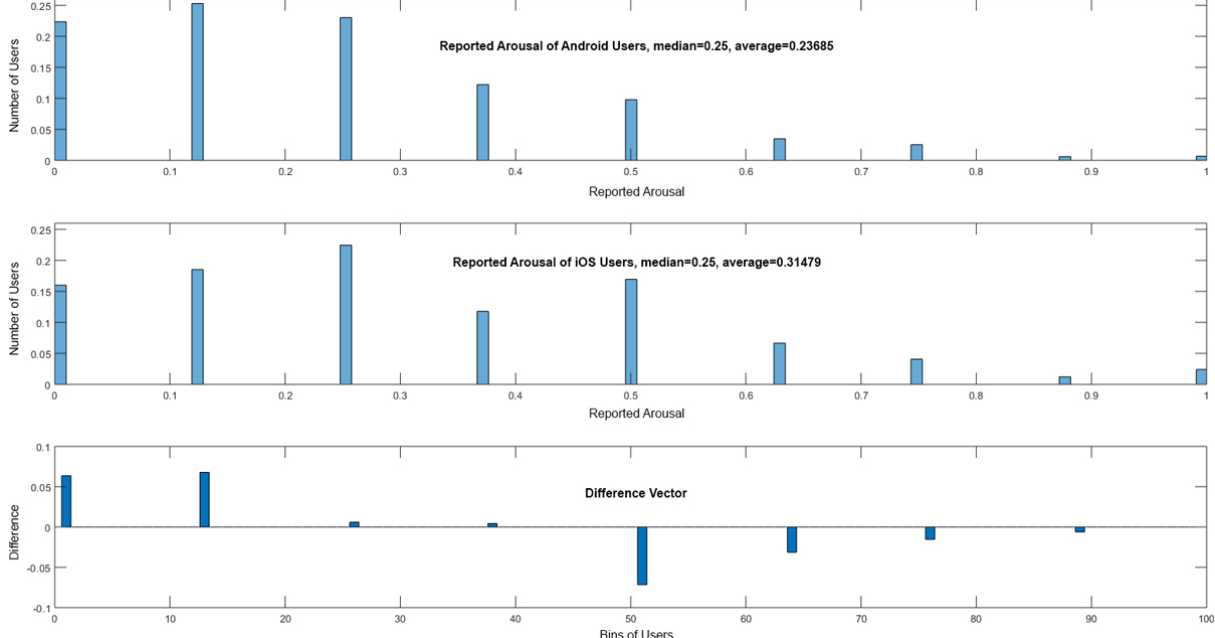
Figure 5. Answers to question 5 ”How is your arousal right now? (manikins)” and the difference vector of Android and iOS